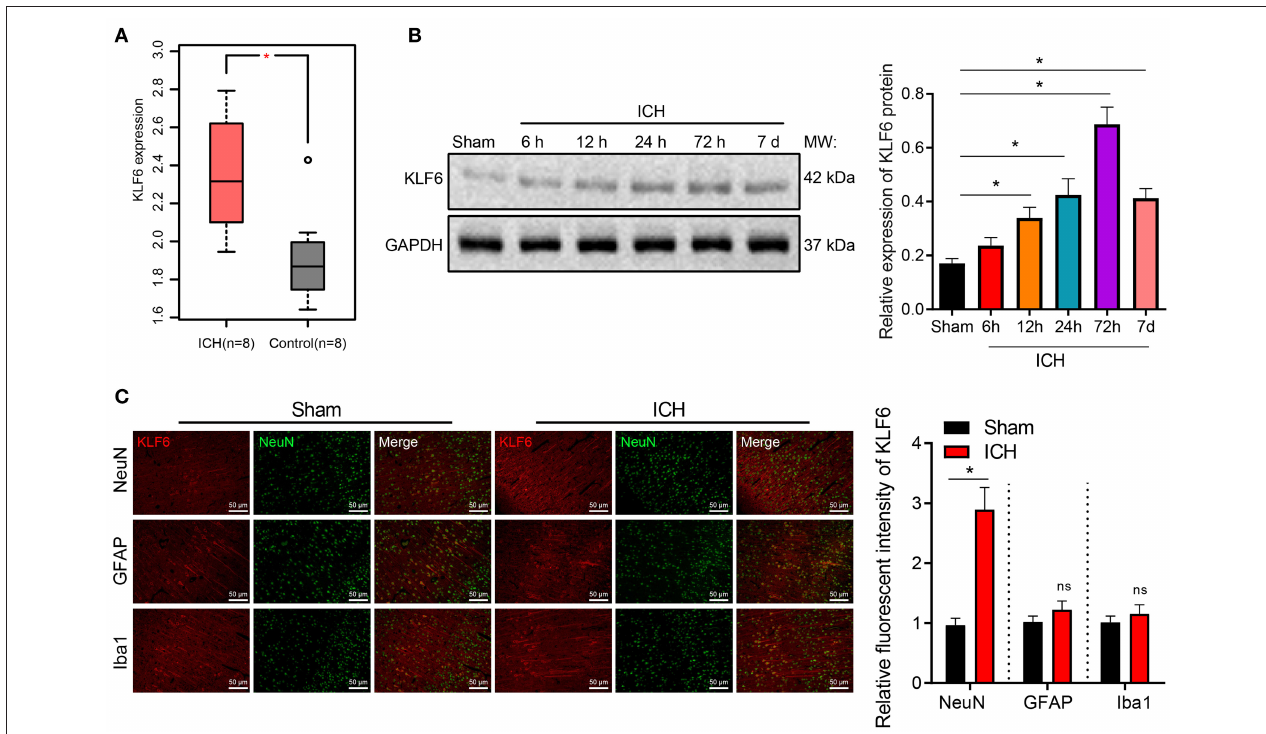
FIGURE 1 | The expression of KLF6 is high in hippocampal neurons of ICH model rats. (A) The expression of KLF6 in the ICH-related microarray GSE149317. The box diagram shows the expression of KLF6 gene; the red one indicates the ICH group, and the gray one indicates the normal group. (B) KLF6 expression in rats at different time points (6, 12, 24, 72h, 7 days) after ICH modeling determined by Western blot analysis. (C) KLF6 expression and location in different neurons detected by immunofluorescence staining. * p < 0.05 compared with sham-operated rats. The measurement data were expressed as mean ± standard deviation. Comparisons between two groups were analyzed using unpaired t -test, and comparisons among multiple groups were tested by one-way ANOVA followed by Dunnett post-hoc test. n = 6